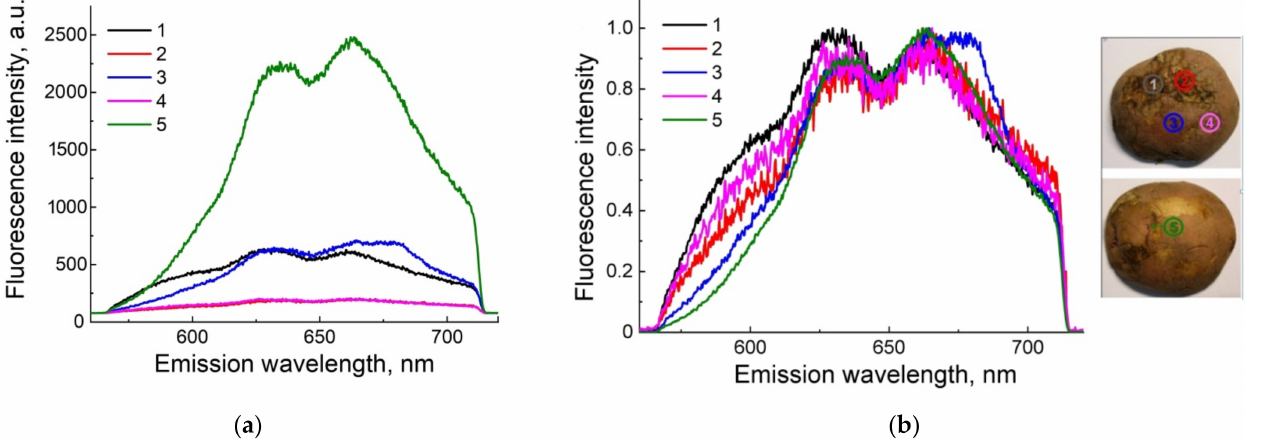
Figure 12. Pulsed fluorescent spectra of different surface locations of “Zhukovsky” potato (see sampling spot in the insets). ( a ) Original spectra; ( b ) normalized